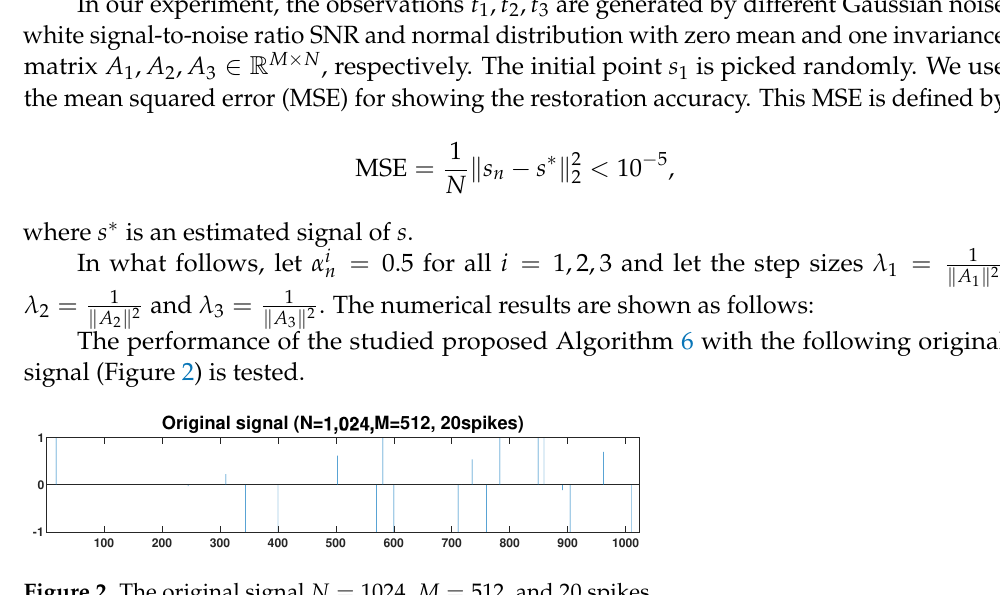
Figure 2. The original signal N = 1024, M = 512, and 20 spikes. The different types of blurred matrices A 1 , A 2 and A 3 are shown in Figure 3.